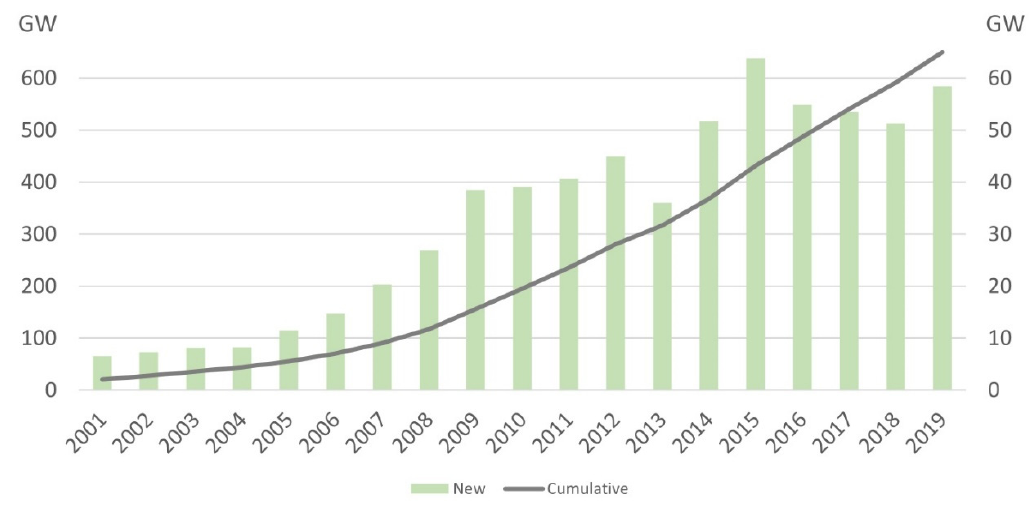
Figure 1. Total cumulative and yearly installed world wind power capacity.